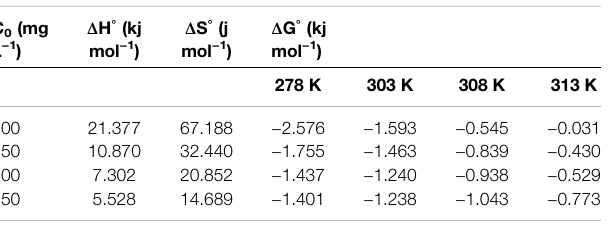
TABLE 4 | Thermodynamic